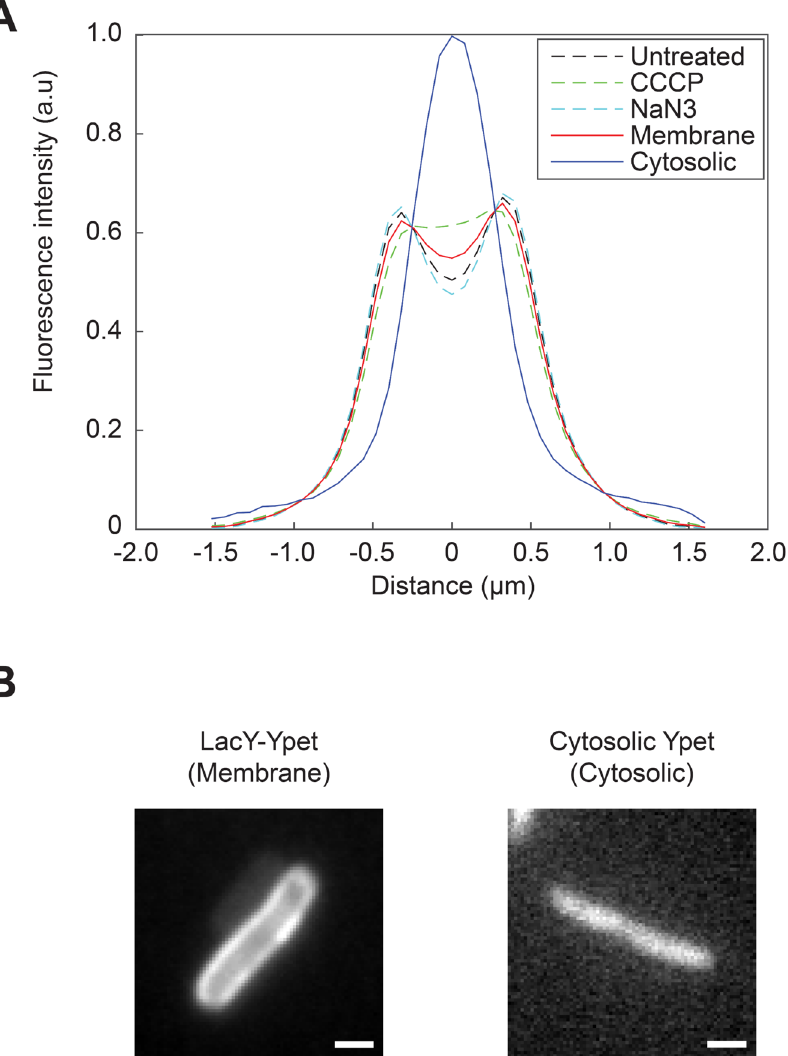
Figure 2. Cellular distribution profiles. ( A ) Cellular distribution profiles of the fluorescence for the membrane protein LacY-Ypet (Membrane, red solid line), cytosolic protein Ypet (Cytosolic, blue solid line) and SecA under native conditions (Black dashed line), treatment with 3 mM NaN 3 (Green dashed line) and treatment with 50 µM CCCP (Cyan dashed lines). ( B ) Z-projections of the membrane marker LacY-Ypet and cytosolic marker cytosolic Ypet. Plots are the result of averaging the fluorescence in the first 10 s into one image with a single frame acquisition time of 30 ms. Scale bar is 1